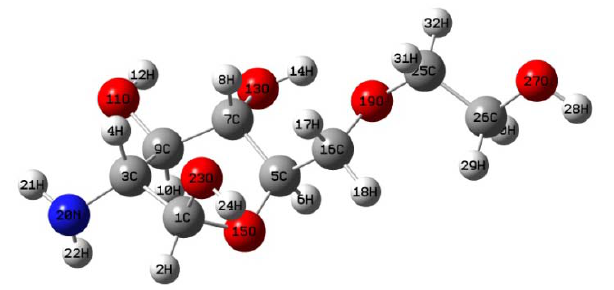
Figure 2. Optimized structure of glucosamine(ethylene